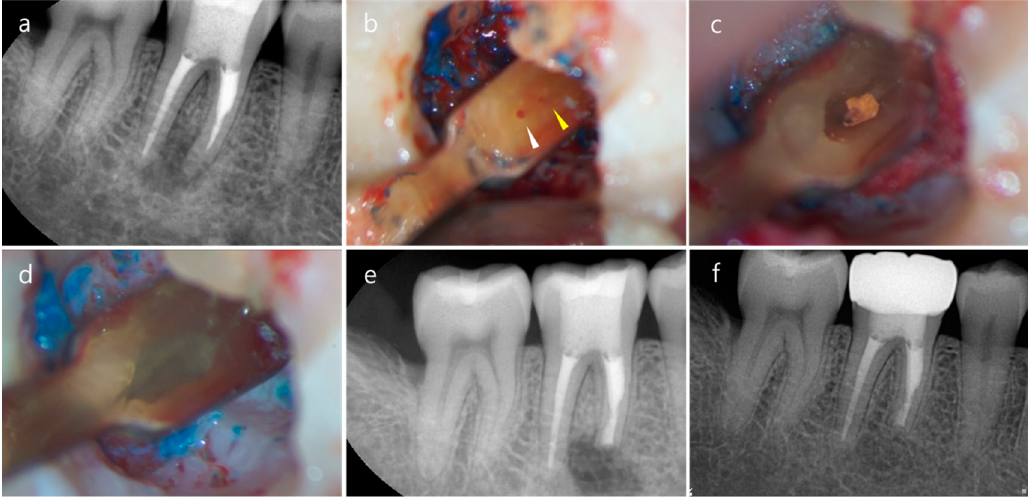
Figure 16. Endodontic microsurgery on an isthmus-absent mandibular molar. ( a ) A preoperative periapical radiograph shows periapical radiolucency and unsatisfactory canal filling on the mesial root due to an unnegotiable ledge. ( b ) The resected root surface shows mesio-buccal (white triangle) and mesio-lingual (yellow triangle) canals, which are closely located without an isthmus at 3 mm from the apex. ( c ) The simple, oval-shaped root-end cavity. ( d ) The root-end filling with mineral trioxide aggregate (MTA). ( e ) A postoperative periapical radiograph. ( f ) A 15-month follow-up radiograph shows that complete healing occurred.